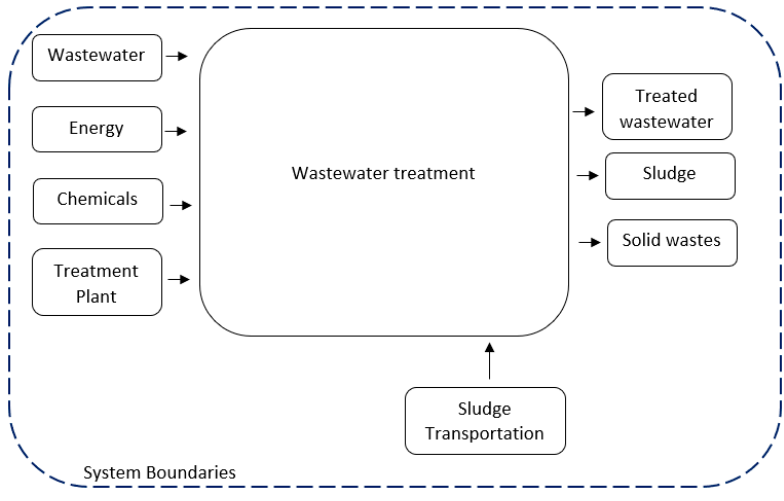
Figure 1. System boundaries.